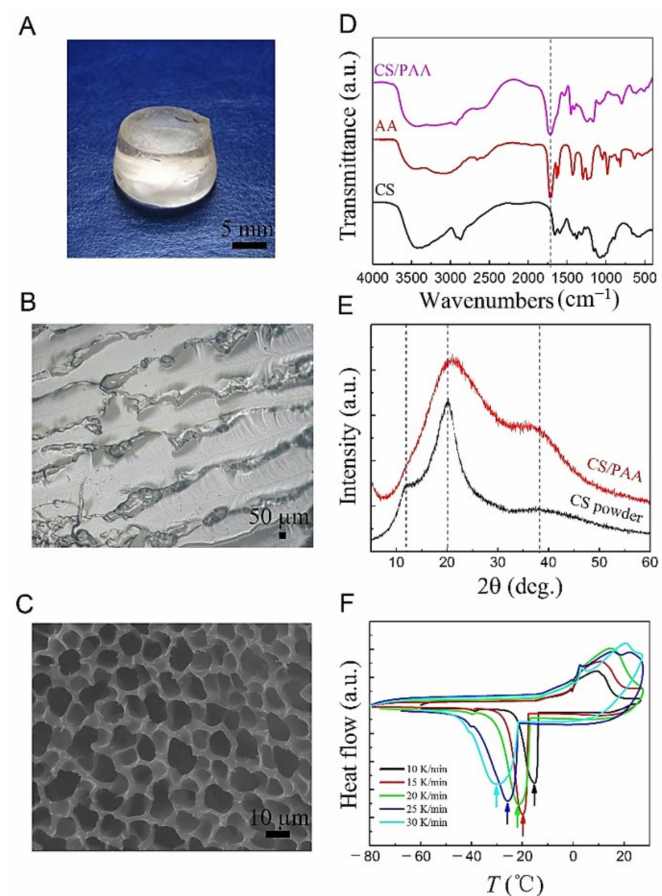
Figure 3. ( A ) Photos of the wet-hydrogels ( f w ~ 0.73). ( B ) Optical photograph of the wet-hydrogels microstructure. ( C ) ESEM image of the dried hydrogels morphology. ( D ) FTIR spectra of chitosan (CS) powder, acrylic (AA) liquid, and dry chitosan-based hydrogels samples. ( E ) XRD patterns of chitosan (CS) powder and dried chitosan-based hydrogels samples. ( F ) DSC curves of chitosan-based hydrogels samples measured in cooling-heating cycles with cooling/heating rates of 10 K/min, 15 K/min, 20 K/min, 25 K/min, and 30 K/min,